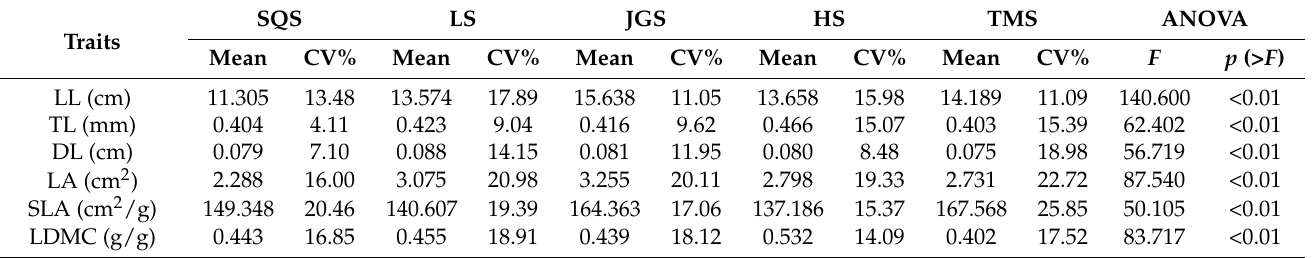
Table 2. Mean values, coefficients of variance (CV%), and analysis of variance of needle traits in P. massoniana . The population abbreviations are the same as in Table 1. Numbers in bold symbolize statistical